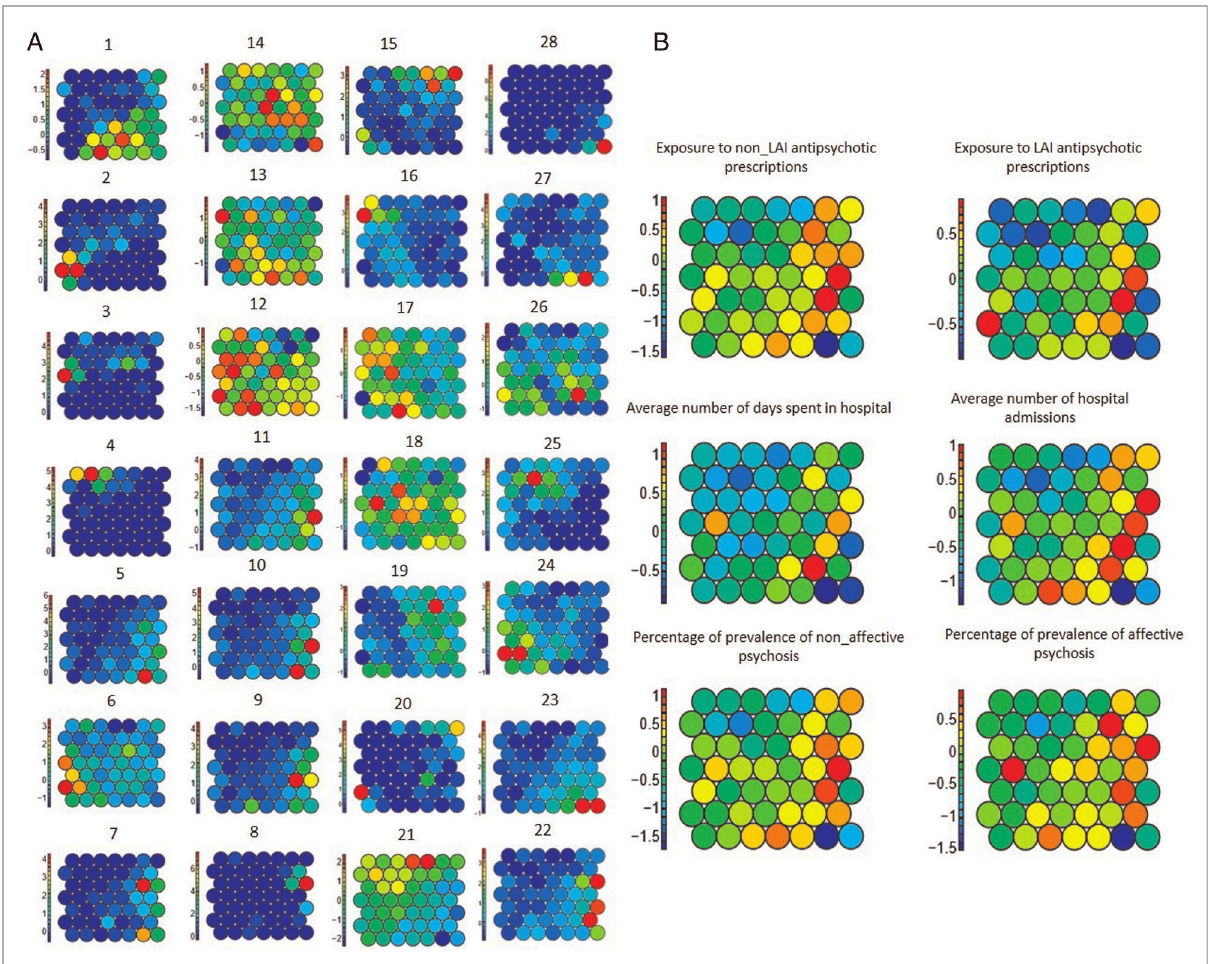
FIGURE 4 SOM of physical features on the left-hand side ( A ) and clinical labels on the right-hand side ( B ); 1 – 28 are based on the numbers assigned to physical features in table 2